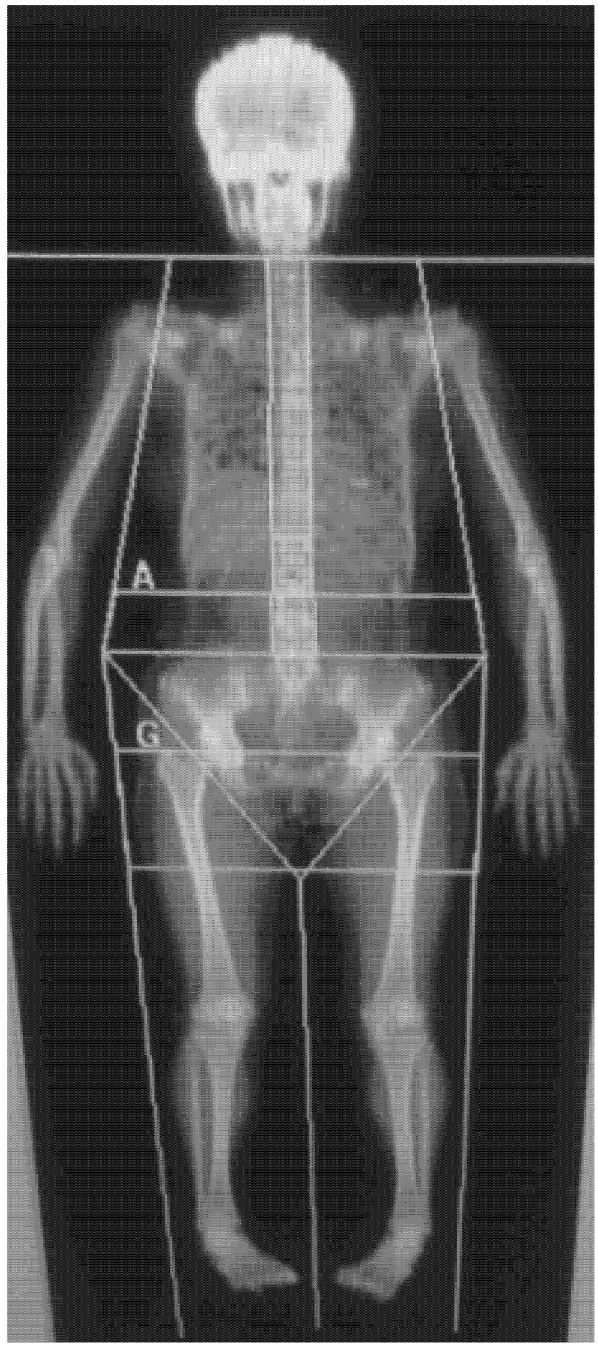
Figure 1. Regions of trunk fat, android (A) fat, and arm and leg fat as assessed by DXA. The trunk region is defined as the area between an upper horizontal border below the chin and a lower border formed by oblique lines passing through the hip joints. The android (A) region is defined as the area between a lower boundary at the pelvis cut and an upper boundary above the pelvis that is 20% of the distance between the pelvis and the neck cuts. doi:10.1371/journal.pone.0063339.g001 the WA-indices of FM. In the ANCOVA models, adjustments were made for age, education, energy-adjusted (EA-) intake of protein, calcium, and phosphorus, calcium supplements, daily